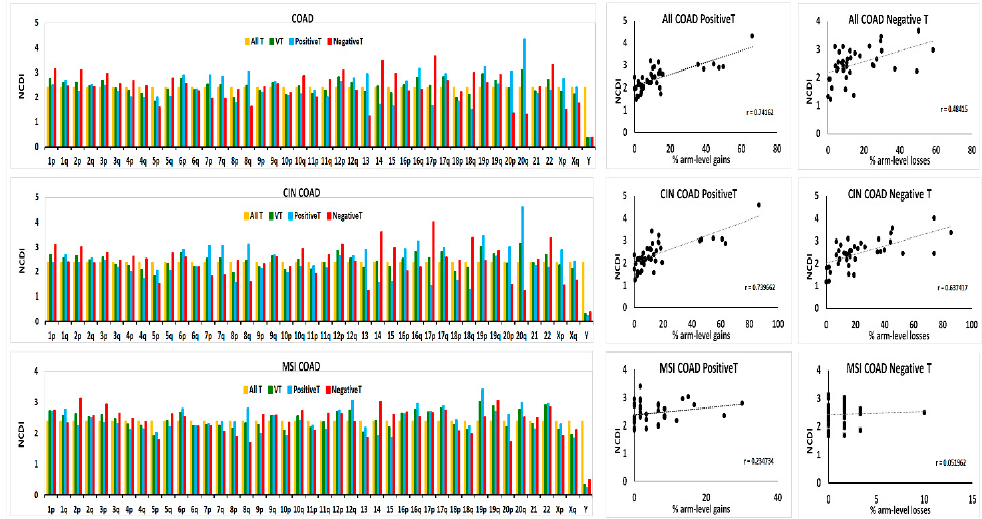
Figure 2. Percentage chromosomal distribution, expressed as NCDI (Normalized Chromosomal Distribution Index—see formula in Materials and Methods), of chromosomal density (number of specific transcripts divided by the total number of transcripts in that chromosome or chromosomal arm) of Variable Transcripts (VT), PositiveT and NegativeT. Values obtained for all transcripts (All T) located in a chromosome or chromosomal arm are also reported for comparison. Results obtained in COAD, CIN COAD and MSI COAD samples are shown in the left panels. Correlation plots of the NCDI values of PositiveT and NegativeT with the frequencies of arm-level gains and losses in each sample group are reported in the right panels. The Pearson’s r index is reported in each correlation plot.